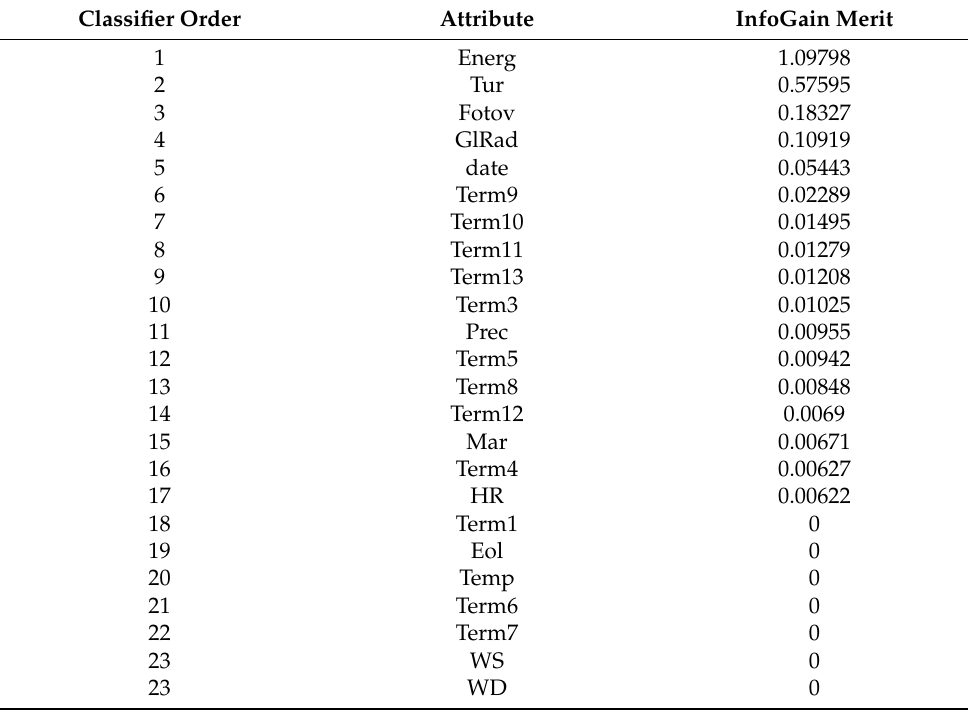
Table 4. InfoGain evaluator attribute